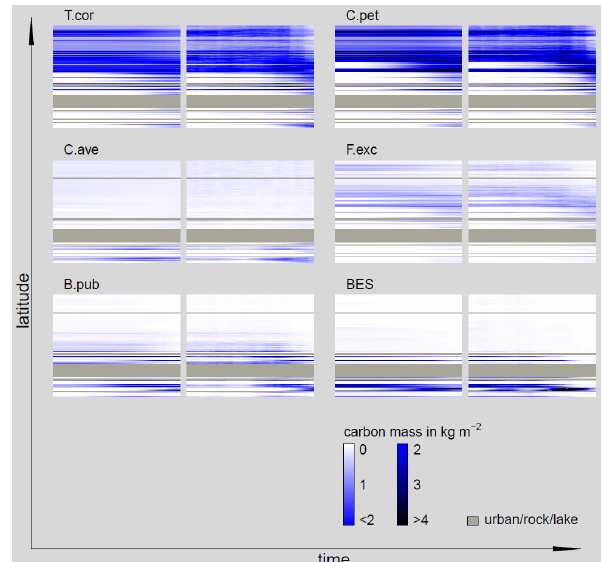
Figure D9. Carbon mass development of the minor species along the analyzed transect using the stochastic (100 stochastic replicates) LPJ- GUESS approach (right) and the GAPPARD method (left), both with the standard parameter set. The timescale in each plot extends from 1900 (left side) to 2100 (right side). See Fig. D3 for species abbreviations. Please note that a different color gradient was used than in Fig.